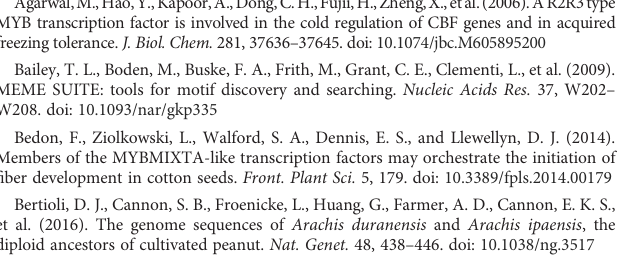
SUPPLEMENTARY FIGURE 3 Phylogenetic NJ tree constructed with 126 Arabidopsis and 196 peanut R2R3- MYB proteins. Bootstrap values were on the branch node. The subgroup labels were marked on the right side of the tree. SUPPLEMENTARY FIGURE 4 Phylogenetic NJ tree constructed using 196 AhR2R3-MYB proteins. Bootstrap values were displayed at the branch nodes. The subgroup labels were labeled on the right side of the tree. SUPPLEMENTARY FIGURE 5 10 MEME motif sequence logos in